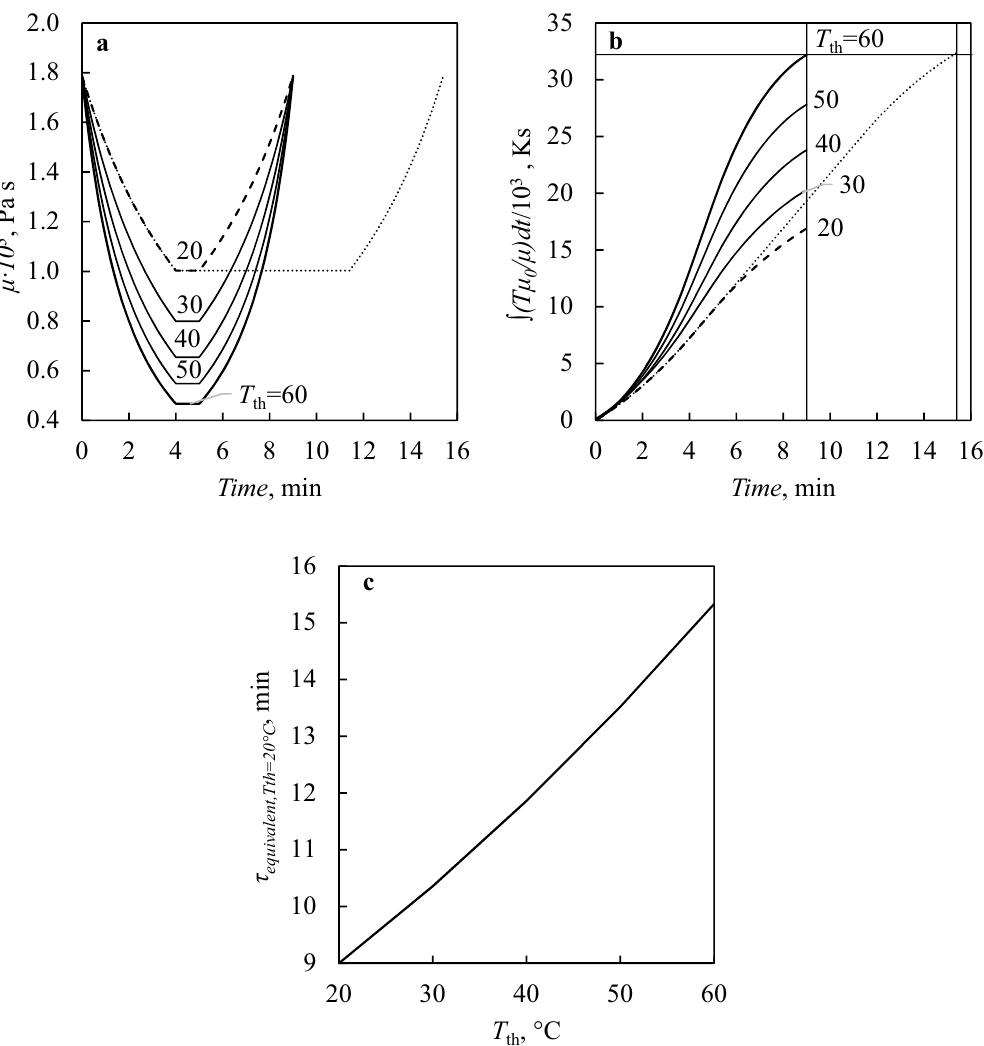
Figure 4. ( a ) Variation of the water viscosity coefficient, µ , with time during tests I-V in Table 1, as computed using Eq. (3). ( b ) Running value of the integral in Eq. (4) over time for tests I-V in Table 1: (solid line) run with T th = 60 °C and τ = 9 min, (dashed line) run with T th = 20 °C and τ = 9 min and (dotted line) hypothetic run with T th = 20 °C and τ = 15.3 min. The remaining solid lines refer to runs with T th = 30–40–50 °C and τ = 9 min. ( c ) Equivalent residence time above 0 °C, τ equivalent , that a freeze–thaw experiment with T th = 20 °C should have to be comparable with runs at different T th and τ = 9